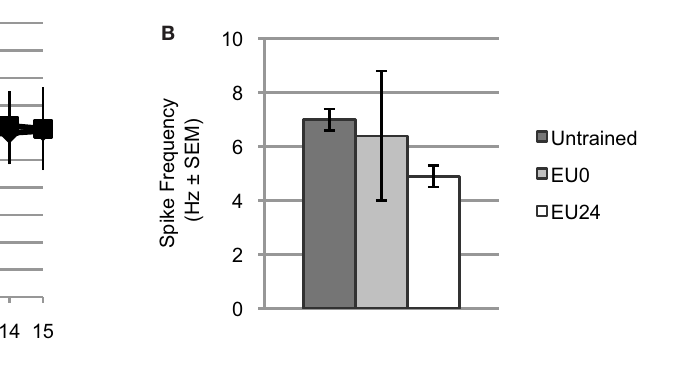
FigurE 5 | Exogenous AA fails to reduce light-evoked spike frequency in Eu0 Hermissenda . (A) When tested immediately after the final training session, AA failed to reduce light-evoked spike frequency in Type B photoreceptors, suggesting